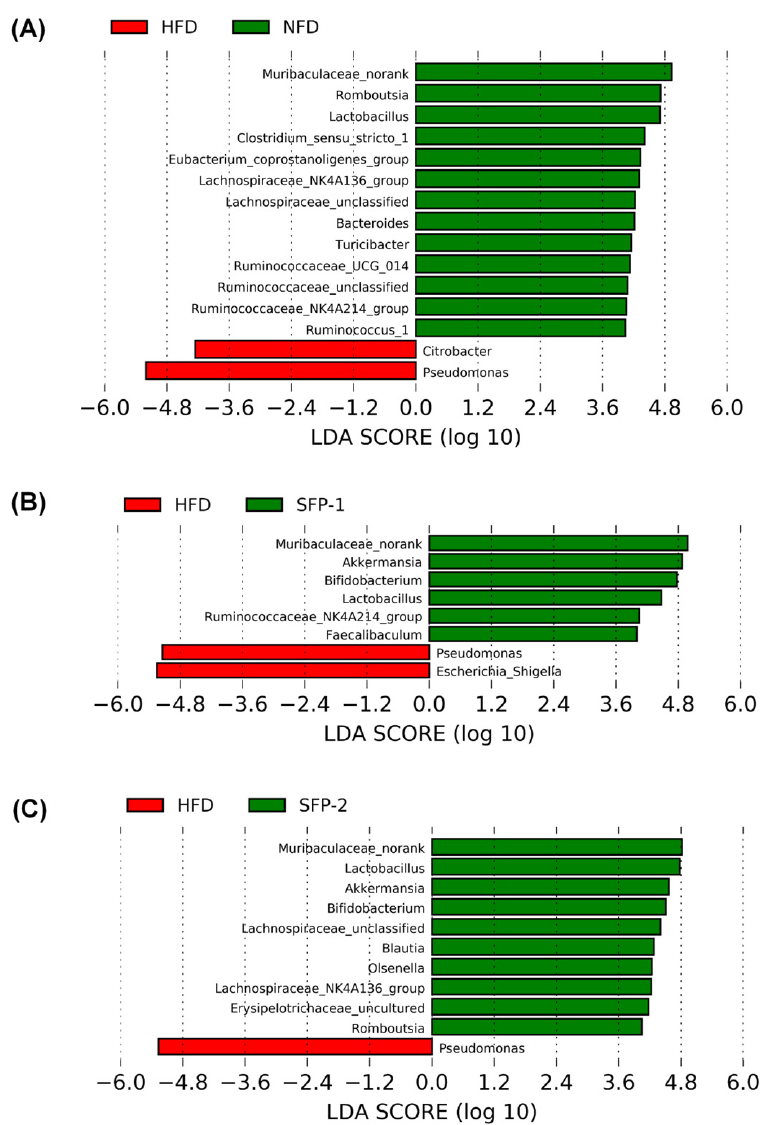
Figure 6. The differences of gut microbiota at the genus levels among groups. LEfSe comparison between HFD and NFD ( A ), LEfSe comparison between HFD and SFP-1 ( B ) and LEfSe comparison between HFD and SFP-2 ( C ). p < 0.05 and LDA score > 4.0 were considered statistically significant.